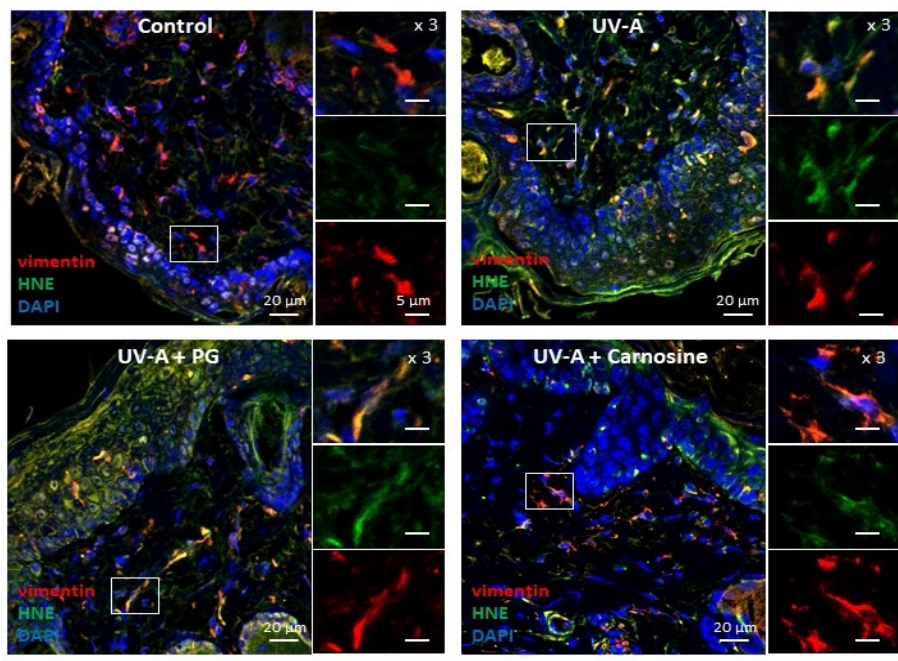
Figure 1. Expression of HNE adducts in fibroblasts in the skins of UV-A-exposed hairless mice. Immunofluorescence pictures (and higher magnification × 3 of each staining on the right of each picture) showing the presence of vimentin in fibroblasts (red), HNE adducts (green), and the merge (yellow). Upper left panel, control (untreated); Upper right panel, UV-A irradiated (20 J/cm 2 /d up to 600 J/cm 2 ); lower left panel, propylene glycol (PG)-treated UV-A irradiated; lower right panel, carnosine (1% in PG)-treated/UV-A irradiated, as indicated in [32]. Scale bar, 20 µm, magnification 5 µm. Nuclei were stained with DAPI (blue). These data are representative of five separate experi- ments.